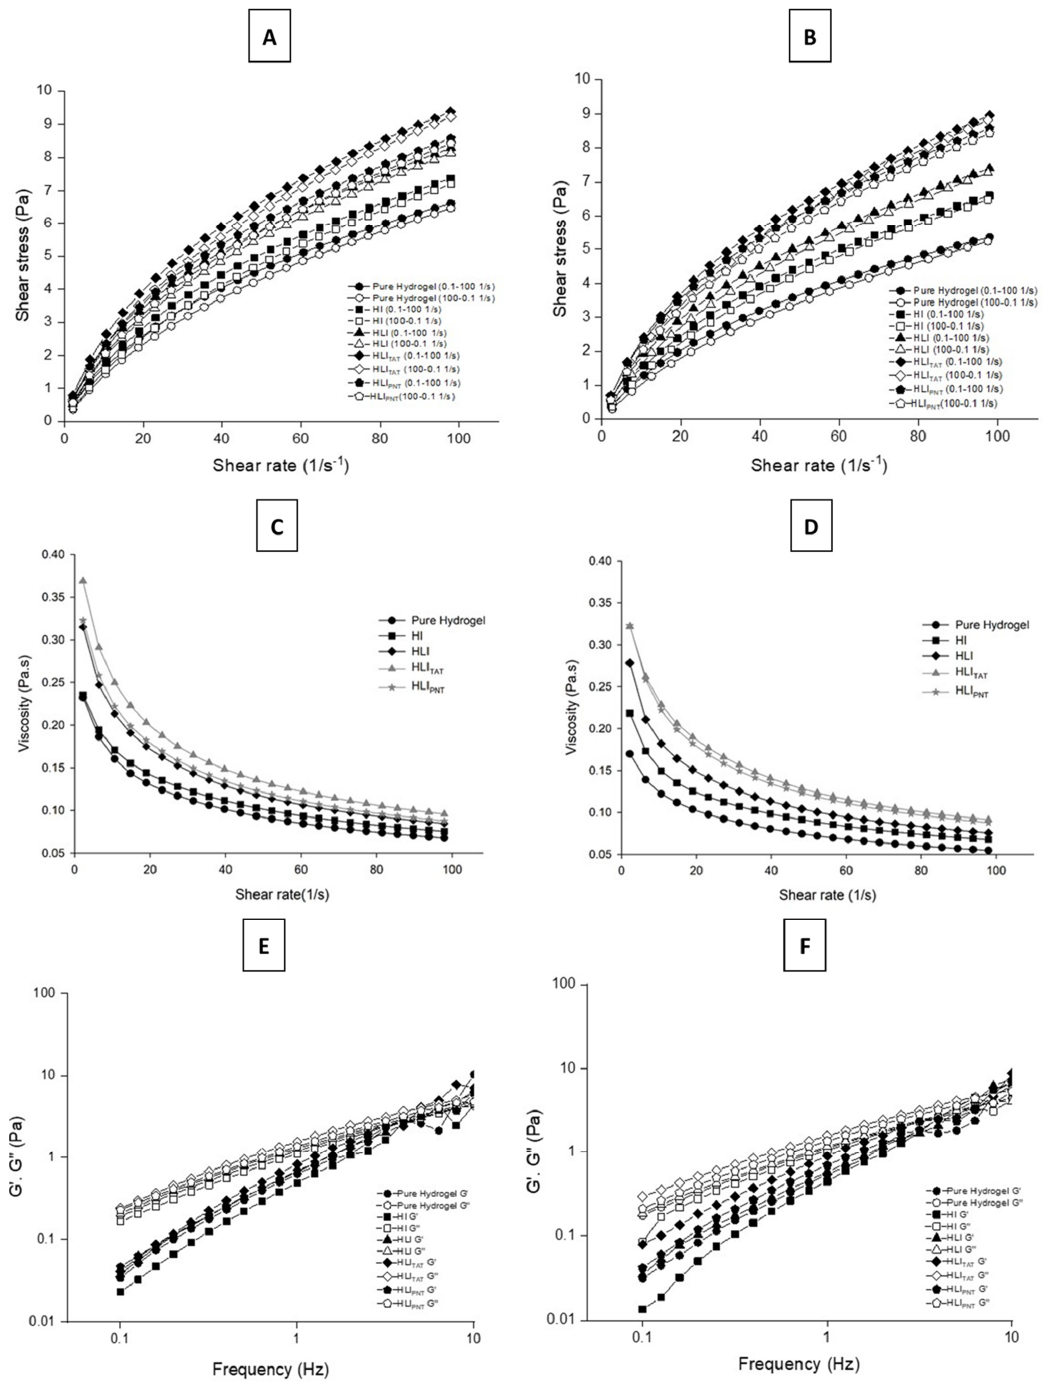
Figure 1. Flow rheograms, viscosity and rheograms of variation in the storage module G ′ (filled symbol) and loss G ″ (empty symbols) as a function of frequency for all formulations at 32 ± 0.5 °C and 37 ± 0.5 °C (n = 3). For flow rheograms, upward curves have filled symbols and downward curves have empty symbols. Pure HEC-based hydrogel; HEC-based hydrogel containing insulin (HI); HEC- based hydrogel containing insulin-loaded liposomes (HLI); HEC-based hydrogel containing insulin- loaded liposomes functionalized with TAT (HLI TAT ); HEC-based hydrogel containing insulin-loaded liposomes functionalized with PNT (HLIPNT). ( A – D ) Rotational tests; ( E , F ) oscillatory measurements. The standard deviations have been omitted for clarity; however, in all cases, the coefficients of variation of the triplicate analyses were less than